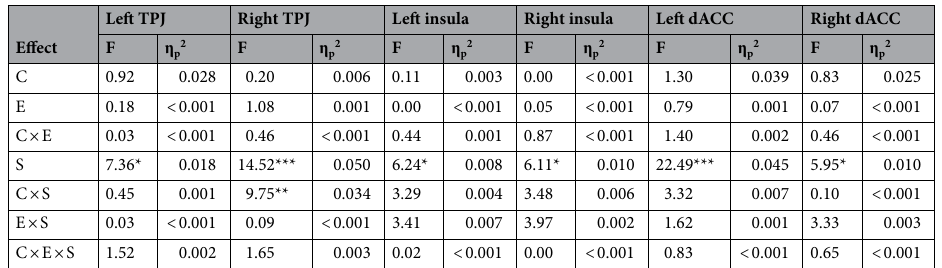
Table 2. Results of mixed design analyses of variance for selected regions of interest. N = 30. Degrees of freedom are 1 and 28 for all effects. C = Comments (neutral vs. hateful), E = Ethnicity (Arab vs. Polish), S = Story (no pain vs. pain). * p < 0.05 * p < 0.01 *** p < 0.001.